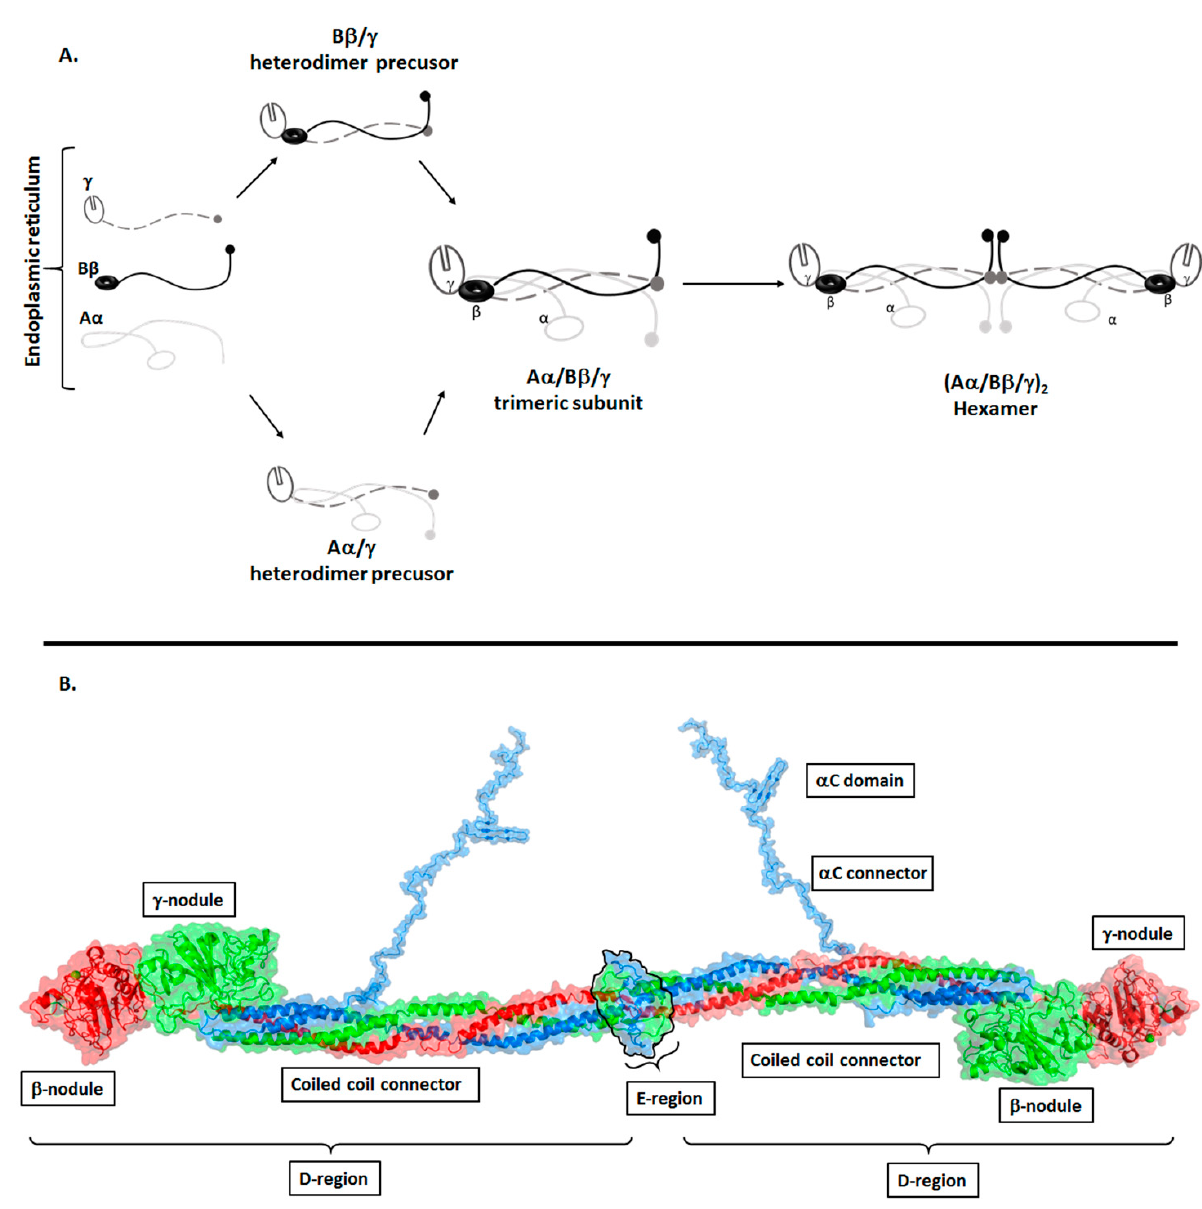
Figure 1. Assembly and structure of fibrinogen. ( Panel A ) Production of fibrinogen in hepatocytes. Once synthesised, fibrinogen chains A α , B β and γ assemble in a stepwise manner. The A α / γ and B β / γ heterodimers are formed first, followed by the (A α /B β / γ ) trimeric subunit. Once the trimeric subunits are formed, they dimerise in an antiparallel fashion to form the (A α /B β / γ ) 2 hexamer. ( Panel B ) shows a model of the fibrinogen structure based on the crystal structure of fibrinogen (PDB:3ghg) and NMR structure of the α C domain (PDB:2BAF). The assembly of the (A α /B β / γ ) 2 hexamer gives rise to five regions, the E region, two D regions and two α C regions. The E region is the central nodule that comprises of the N-termini of all the chains (A α shown in blue, B β shown in green and γ shown in red). The D region comprises of a triple coiled coil connector and the β - and γ - nodules. The α C domain composed of the A α chain and comprises of the α Connector and α C domain.